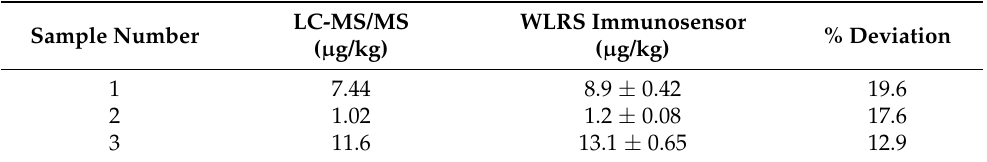
Table 3. Concentrations of OTA determined in corn flour samples by the developed immunosensor and the reference LC-MS/MS method.